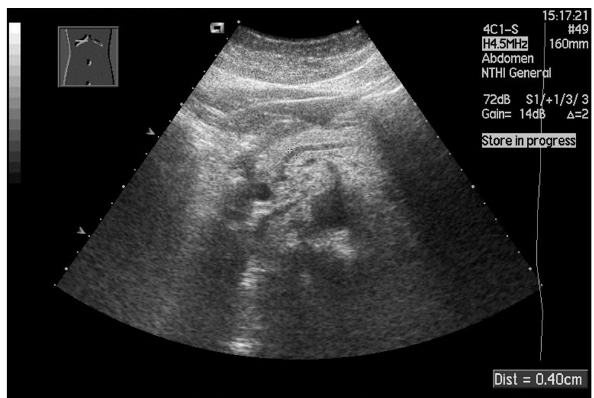
Fig. 1. Abdominal ultrasound imaging: pancreas with 4 mil- limeter pancreatic duct